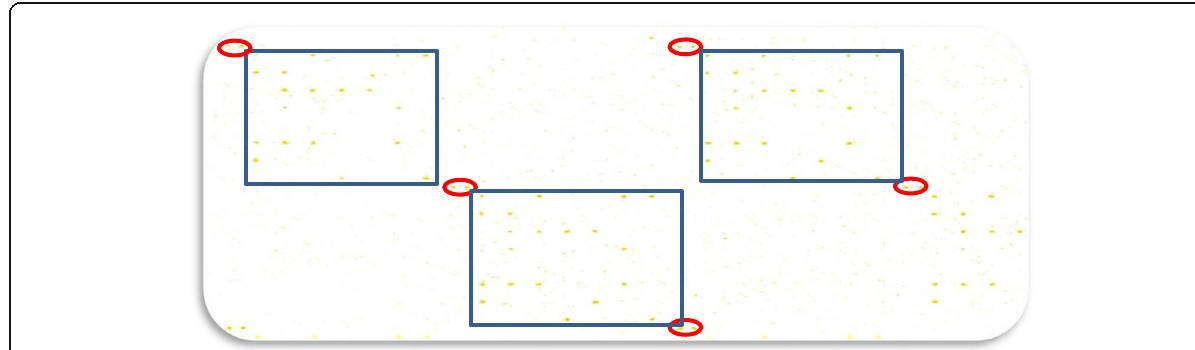
Fig. 6 The CMYK mode of the active yellow dots spread and grouped as the regular grid pattern in the horizontal rows and the vertical columns of Ricoh ® SP C 410 DN sample